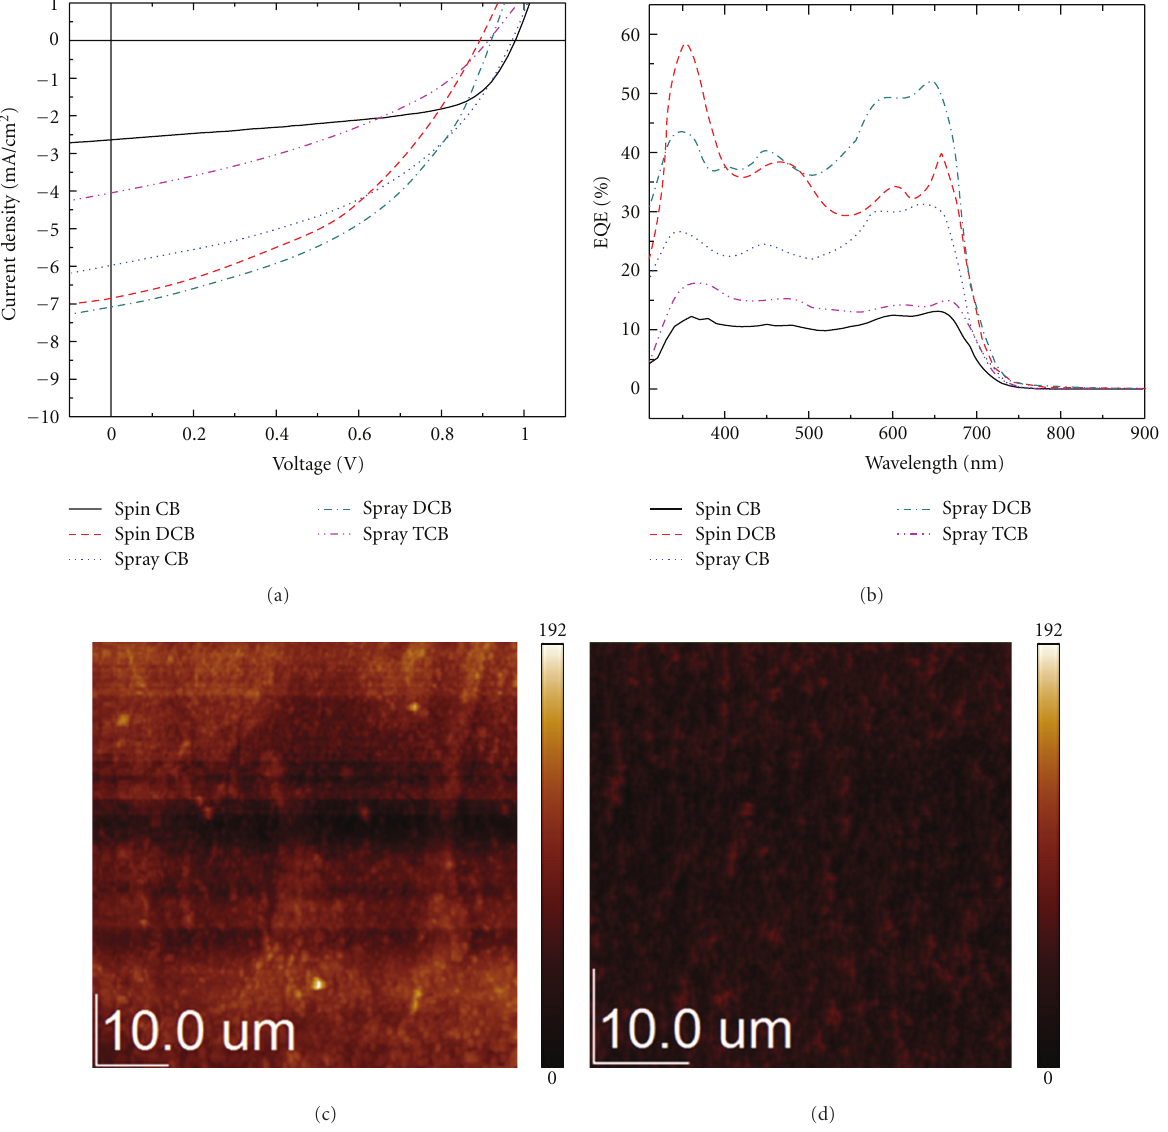
Figure 2: (a) I - V character under illumination and (b) EQE for spin and spray-coated device using di ff erence solvents; AFM images for (c) spray-coated and (d) spin-coated device; the scale bar for AFM is in units of nm.